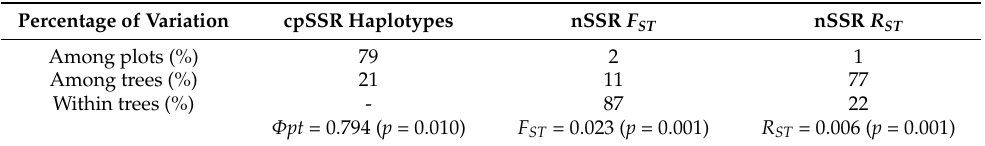
Table 4. AMOVA classification of genetic diversity based on cpSSR haplotypes, F-statistics of nSSR markers using allele distances and R-statistics of nSSR markers using microsatellite